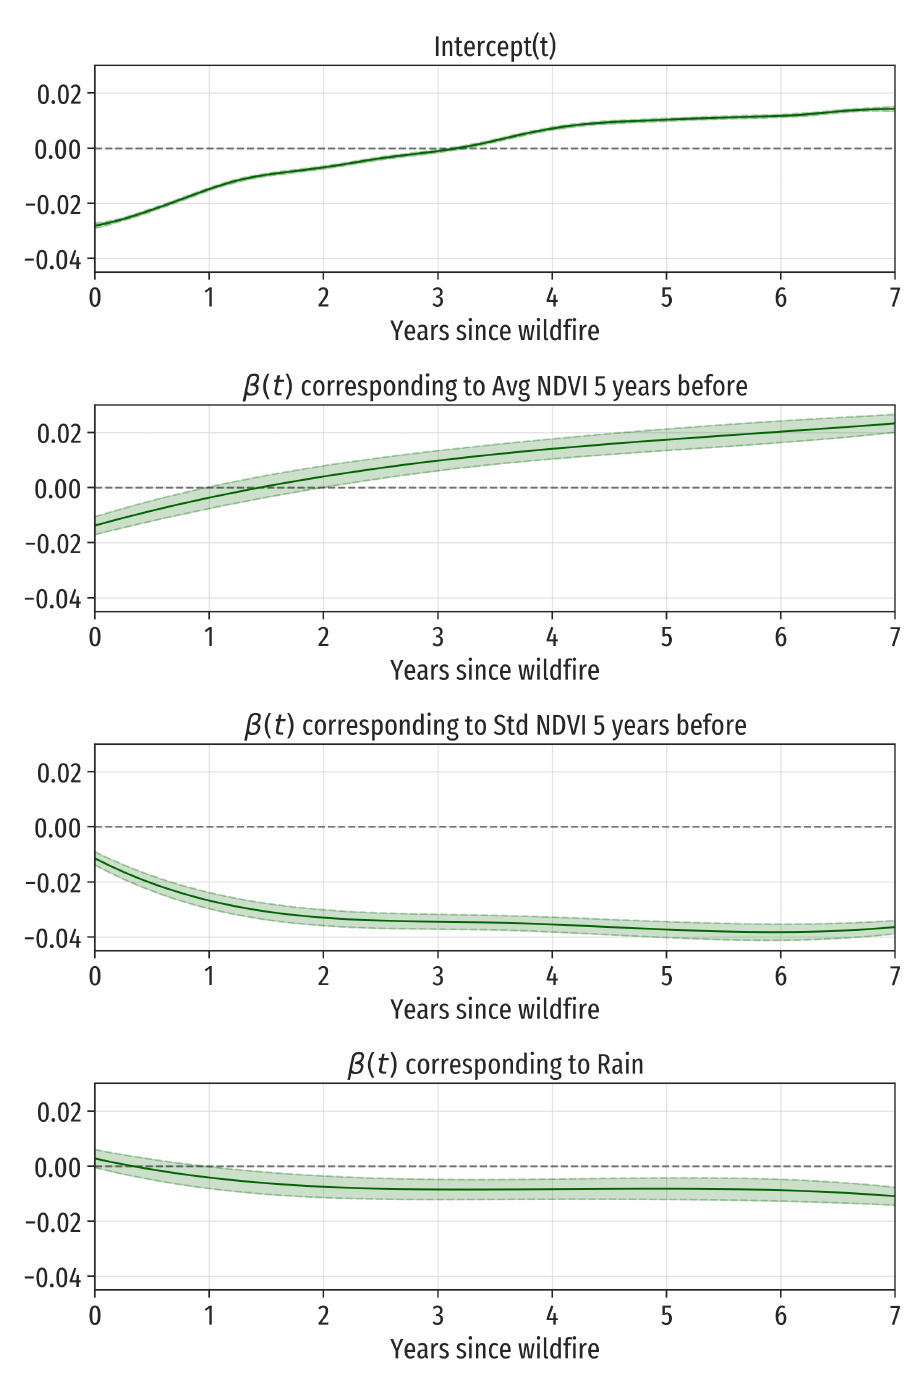
Figure 7. Full function-on-scalar additive model. Estimated functional coefficients of the form β j ( t )